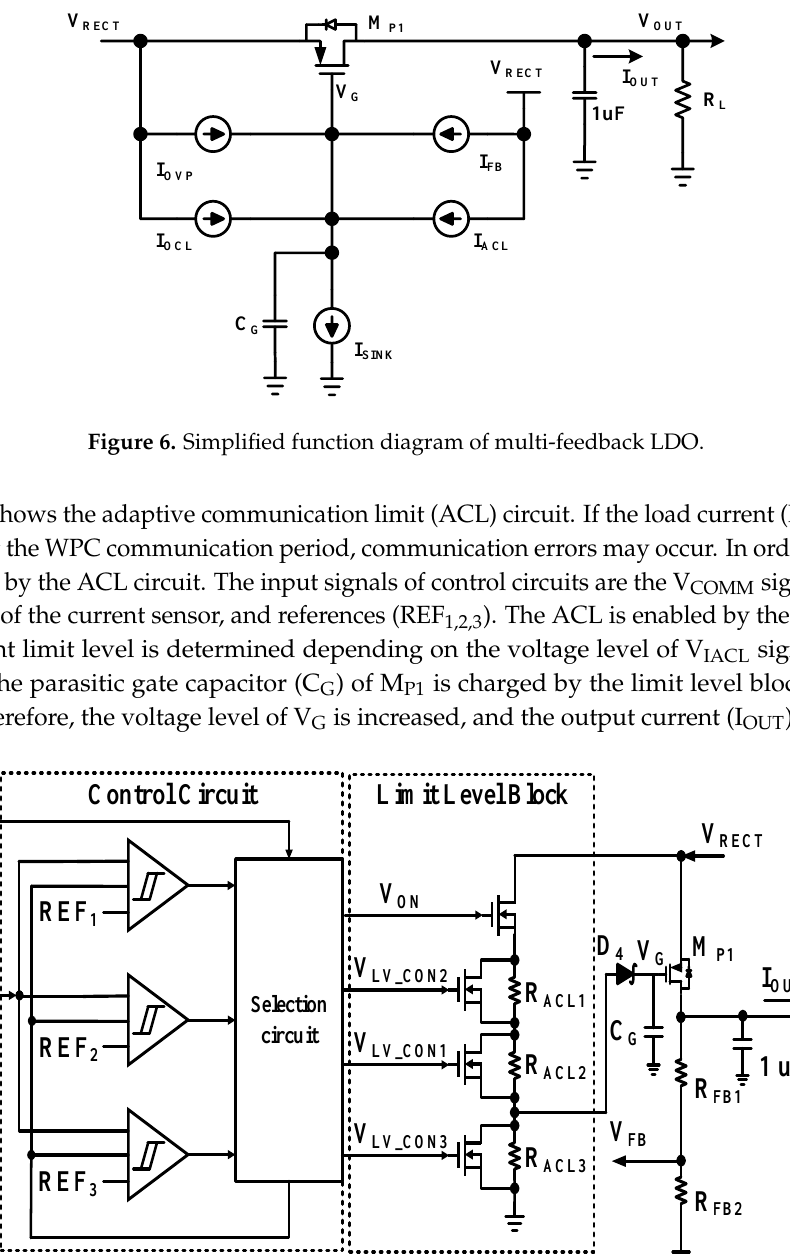
Figure 5 . Multi-feedback LDO (MF-LDO) regulator.